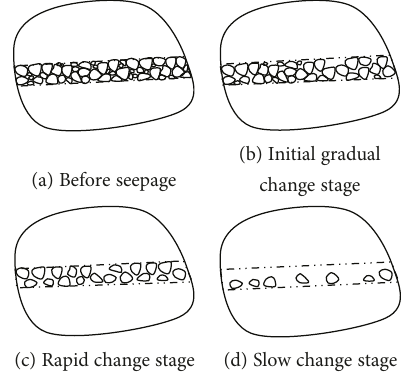
Figure 7: Schematic of migration and dissipation of fi ne particles in the test samples with gradations of n = 0 7 –